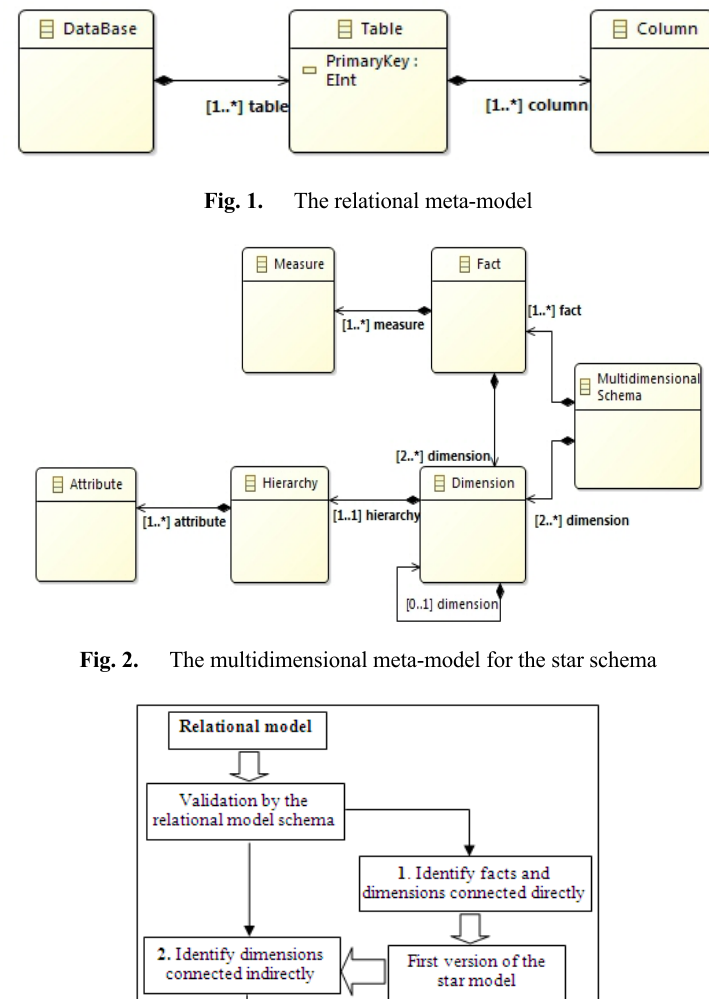
Fig. 1. The relational meta-model